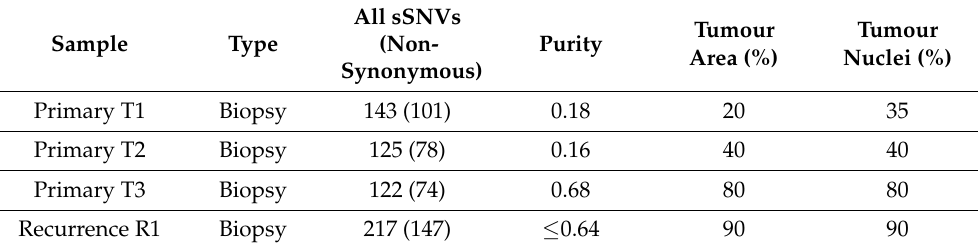
Table 1. Clinical, sequencing and histological profile of samples investigated in this study. Sample type, number of sSNVs (total number and non-synonymous sSNVs in parentheses) detected in the WES data, tumour purity estimated by the mutation detection pipeline, tumour area, and tumour nuclei from the histological inspection are shown for each sample. All sSNVs Sample Type